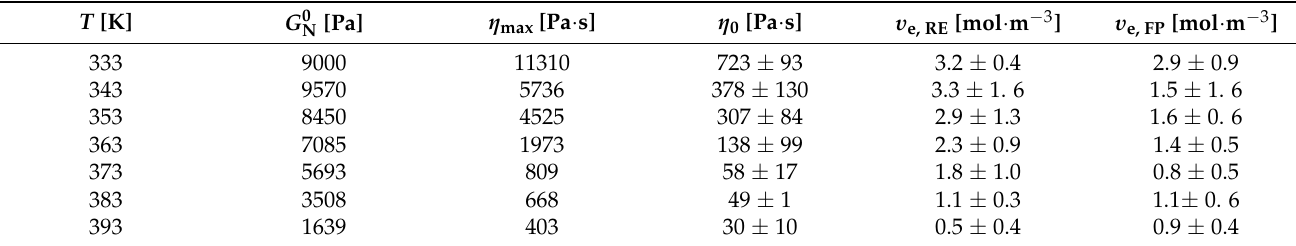
Table 6. Zero-shear viscosity, η 0 the molar density of elastically active strands, ν e,FP and υ e,RE calculated using the free path model and rubber elasticity assumptions respectively and the maximum viscosity at studied temperatures.